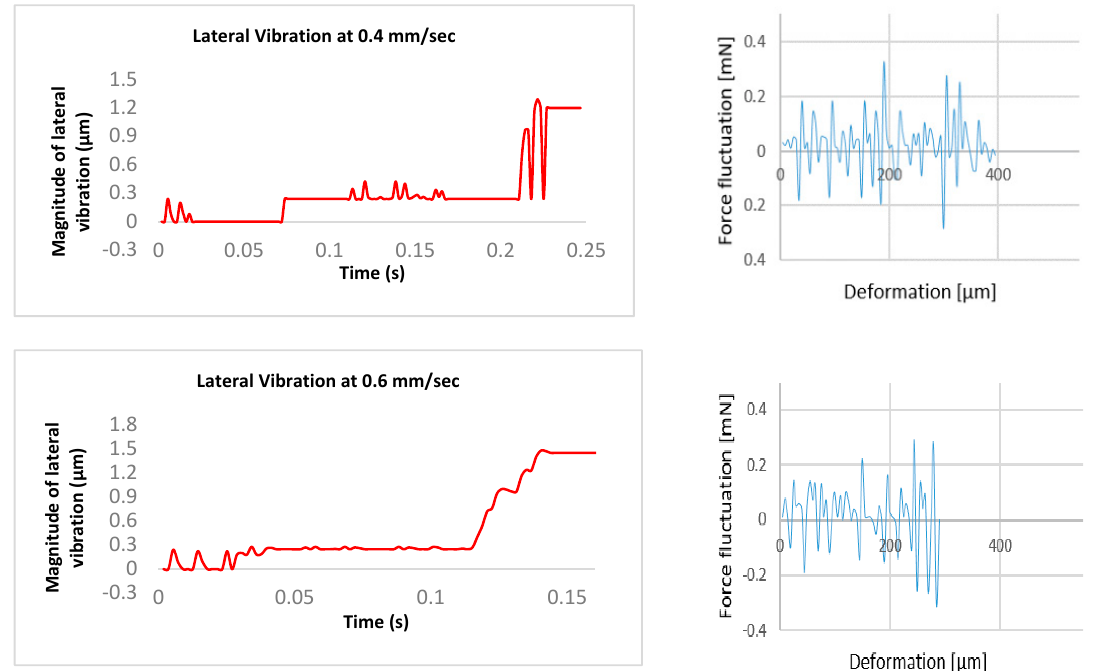
Figure 13. Lateral vibration displacement, force fluctuation, and egg deformation at various injection speeds.